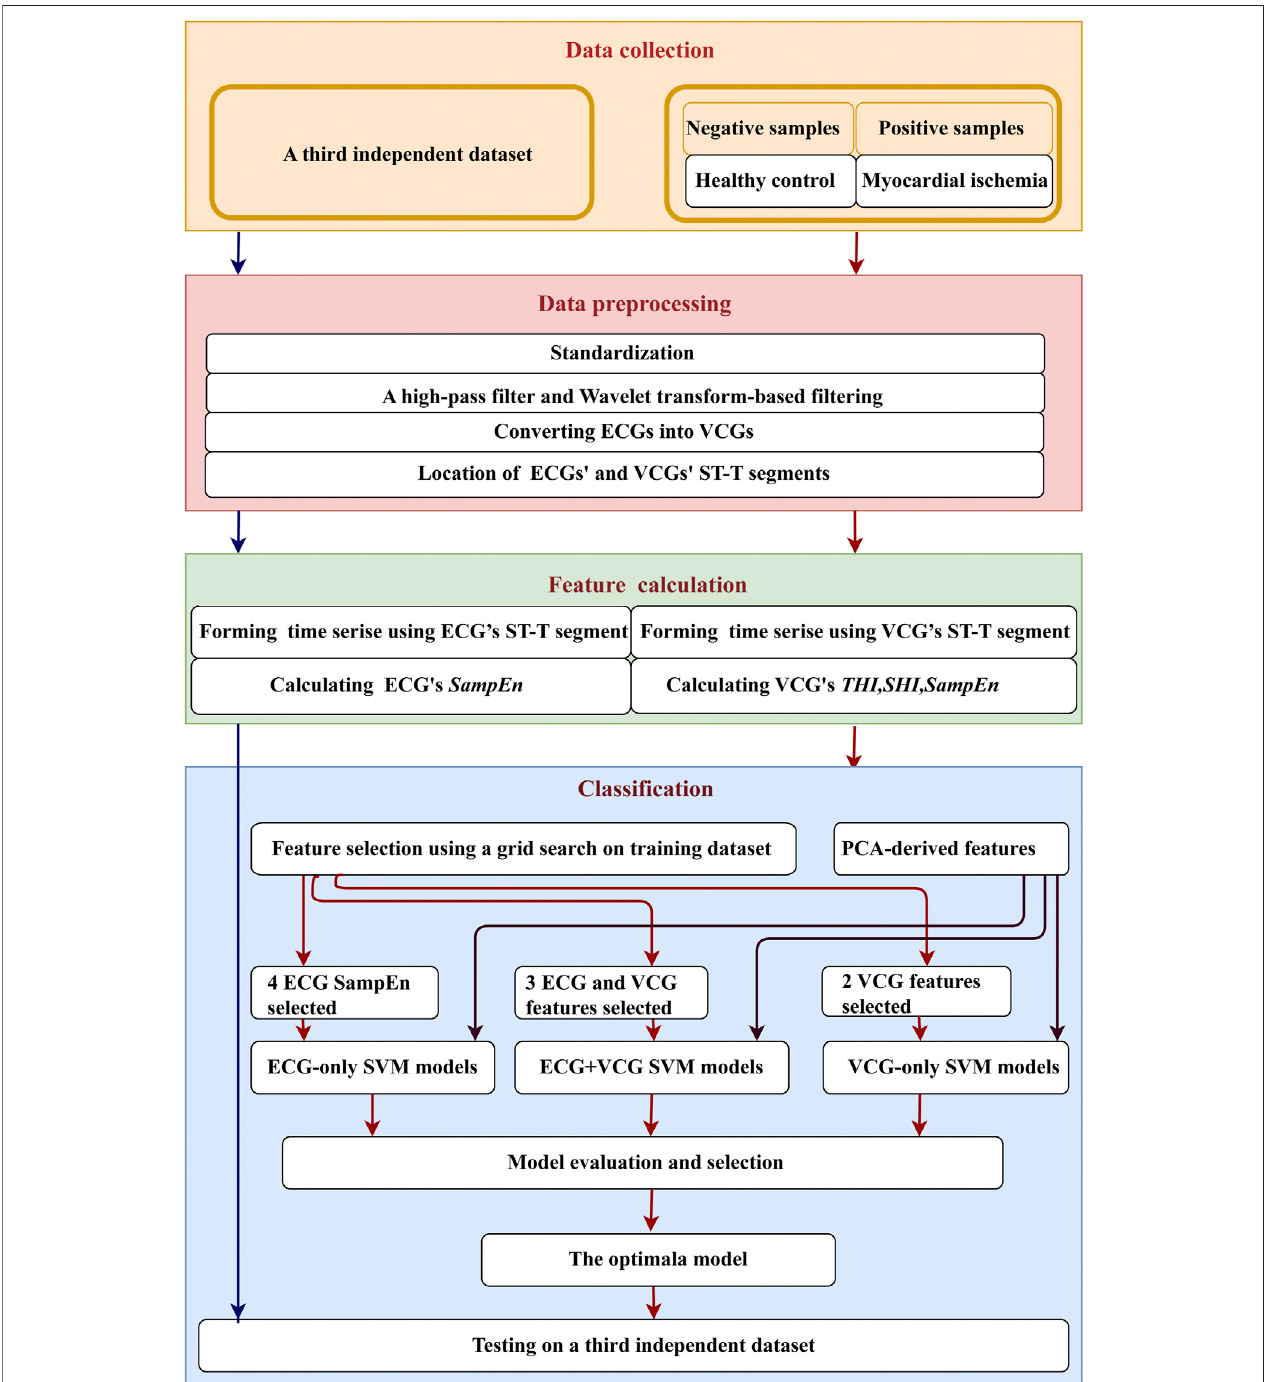
FIGURE 2 | System